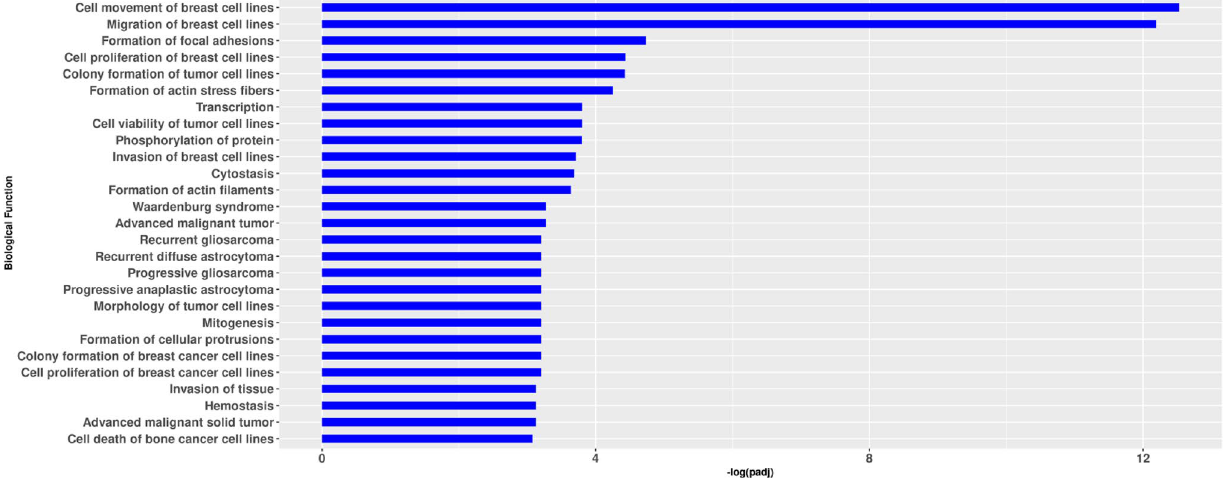
Figure 7. The chosen and validated hsa_circ_0077755 is functionally enriched in cancer-related pathways. A functional enrichment analysis was performed in Ingenuity Pathway Analysis (IPA) of predicted target mRNAs (by TargetScan 65 ) for the top five MREs associated with hsa_circ_0077755. P-values were adjusted for multiple testing using the Benjamini–Hochberg method. The ba r plot displays the biological functions on the y-axis and the –log (adjusted p-value) on the